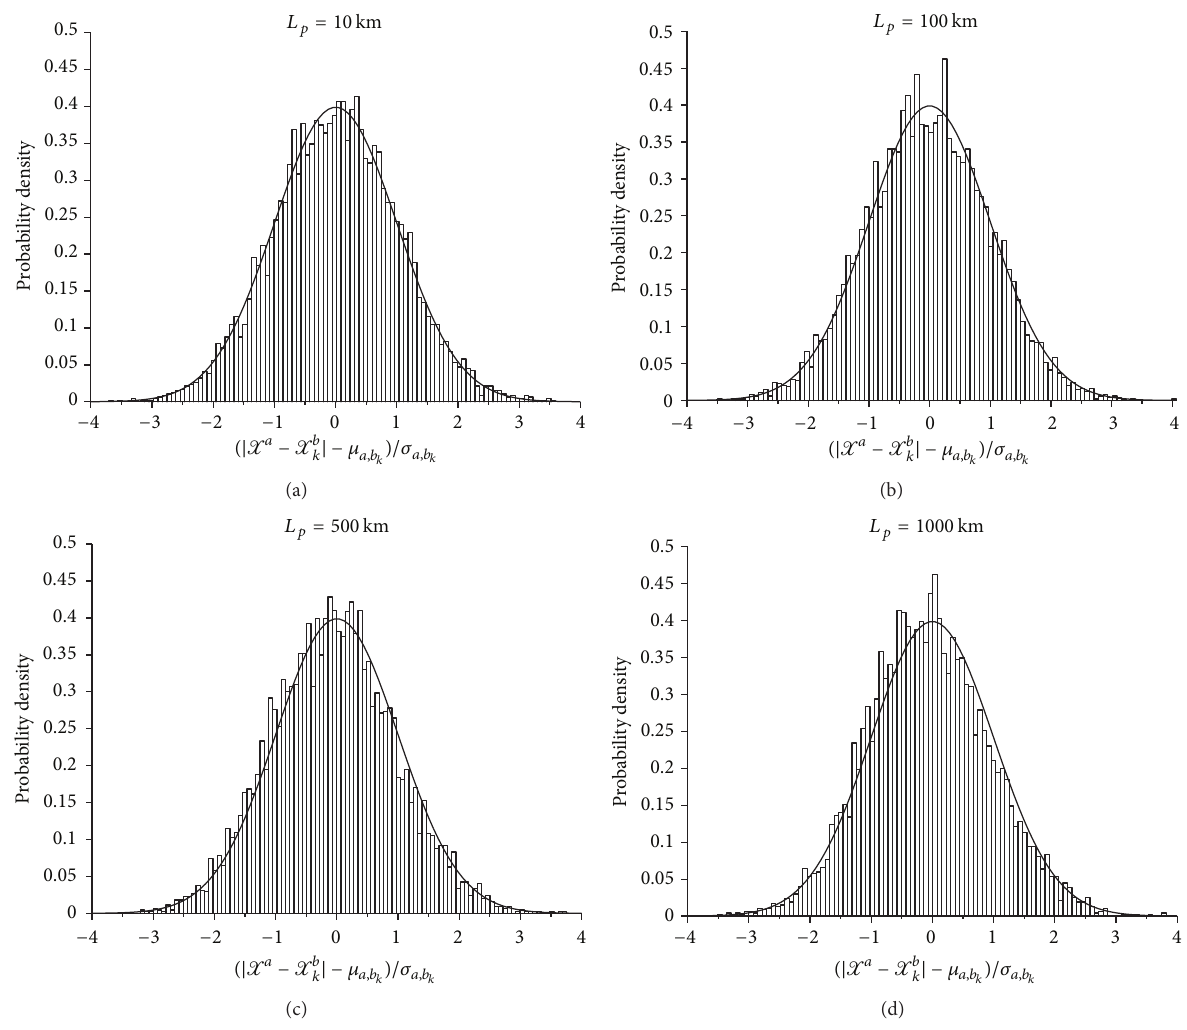
)/𝜎 𝑎,𝑏 𝑘 deduced from the EnKF (and valid here for the PF 𝑘